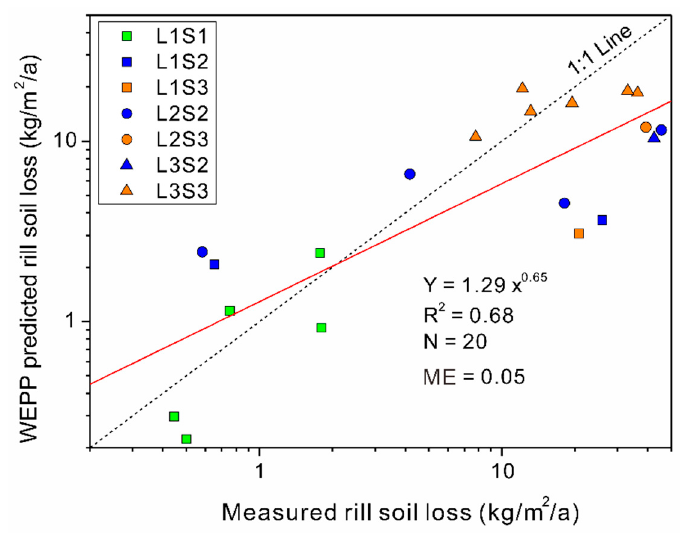
Figure 3. The relationship between the TLS-measured and WEPP-predicted rill soil loss values. L1, L2 and L3 represent road segment lengths shorter than 100 m, 100 m–200 m and longer than 200 m, respectively. S1, S2 and S3 represent road gradients lower than 5%, 5–10% and higher than 10%, respectively.